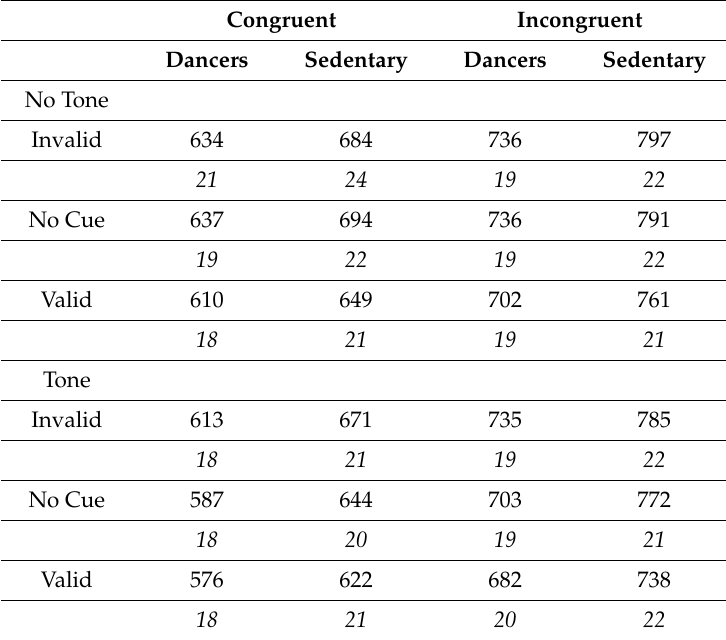
Table 2. Mean RT (in milliseconds), and standard deviations (in italics) for each experimental condition of alerting (no tone, tone), orienting (invalid, no cue, valid), and conflict (congruent, incongruent) in the modified ANT-I task. Congruent Incongruent Dancers Sedentary Dancers